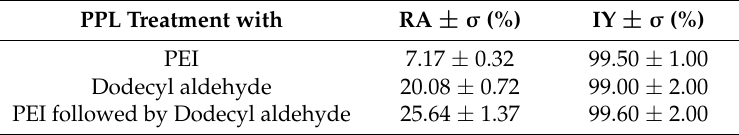
Table 2. Evaluation of the treatment of porcine pancreas lipase (PPL) with polyethyleneimine (PEI) and dodecyl aldehyde on the immobilization parameters IY (immobilization yield) and RA (recovered activity). The values are expressed as mean of triplicates ± standard deviation ( σ ).